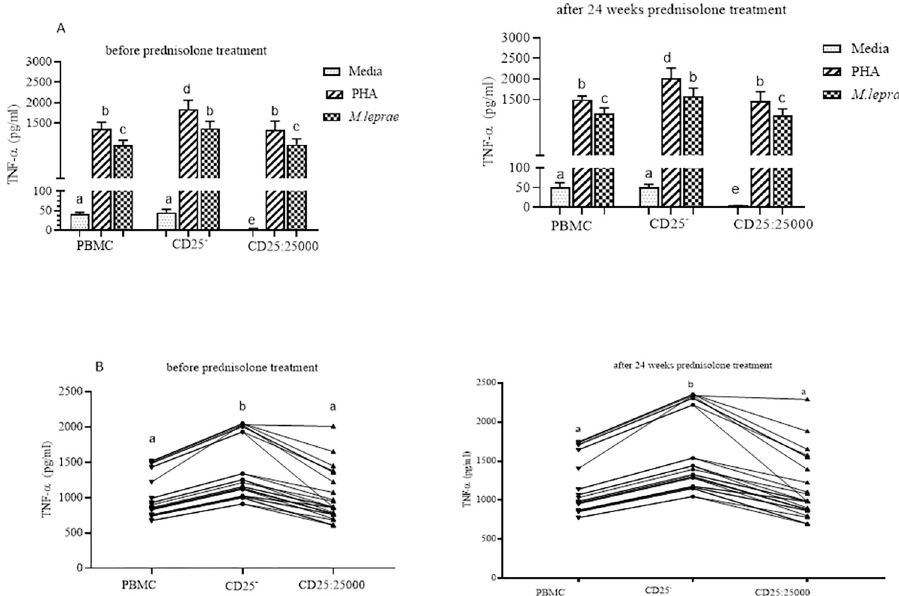
Fig 4. The effect of depletion of CD25 + cells on TNF α secretion by PBMC from ENL participants (n = 30): (Fig 4A) TNF α response to PHA and M . leprae WCS stimulation before and after 24 weeks prednisolone treatment of individuals with ENL; (Fig 4B) TNF α response to M . leprae WCS stimulation in control PBMC, CD25 + depleted PBMCs and CD25 + re-added cells to CD25 + depleted PBMC from individuals with ENL before and after 24 weeks of prednisolone treatment. Each bar and line graph show mean ± 95% confidence interval (CI). CI is calculated for mean difference. Any pair of different letters shows that the mean of TNF α production of the two groups are statistically significantly different at p = 0.05 and any pair of similar letters indicates that the mean of TNF α production the two groups are not statistically significantly different at P � 0.05 and 95% CI. Media indicate AIM-V medium only and it was used in the assay as negative control and PHA used as a mitogen (positive